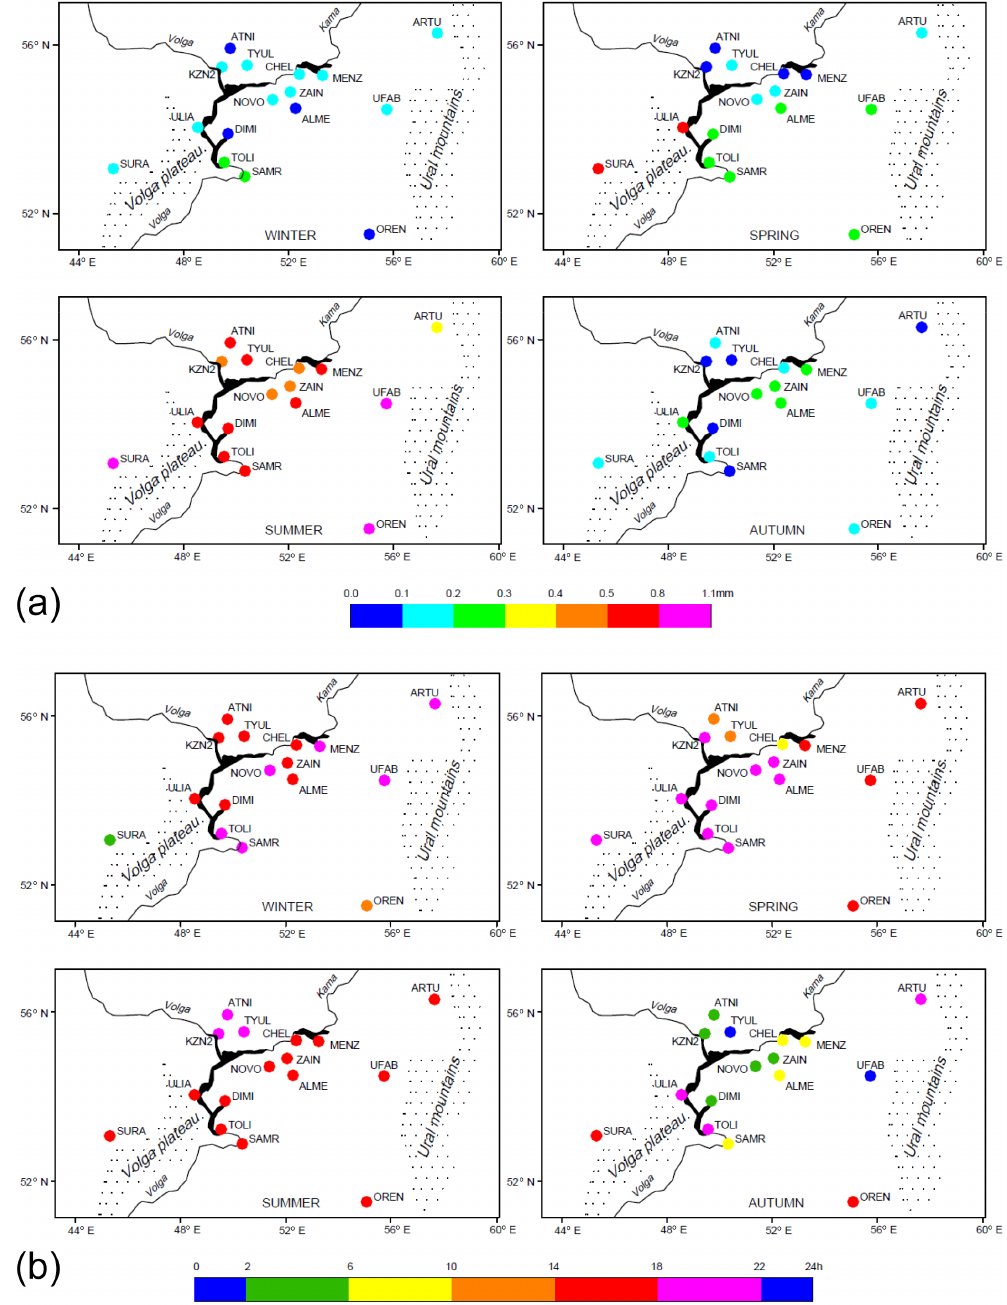
Figure 2. Amplitude (a) and time at the maximum (b) of diurnal